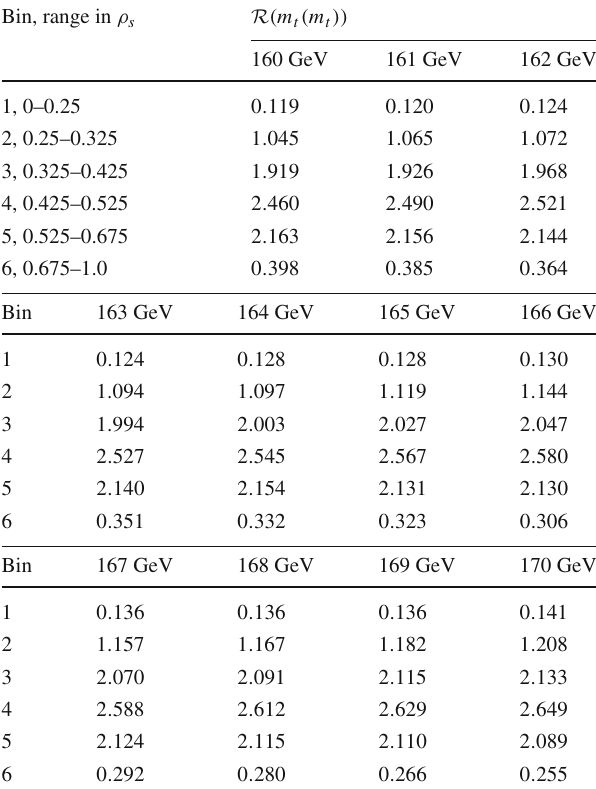
Table 4 Same as Table 1 but for the MSTW2008nlo PDF set. Only the central scale μ = m t ( m t ) is shown Bin, range in ρ